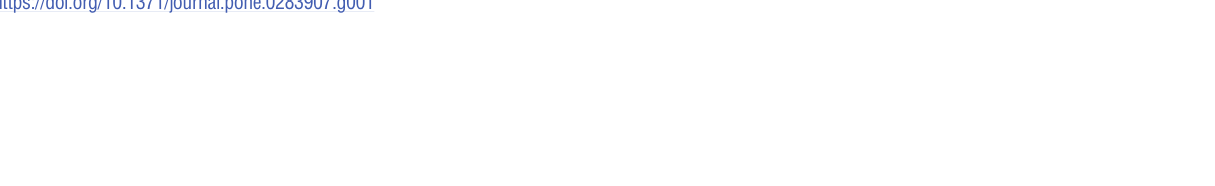
PLOS ONE | https://doi.org/10.1371/journal.pone.0283907 April 7, 2023 4 /